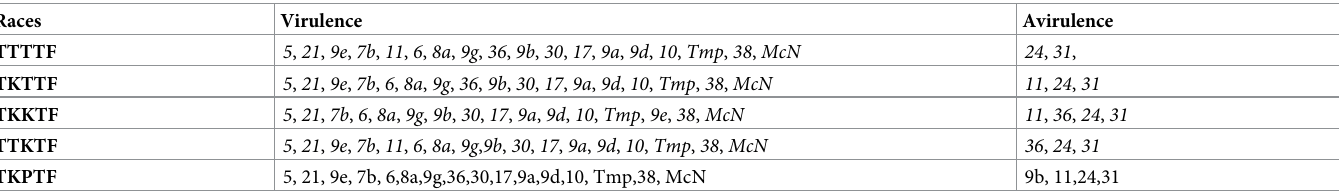
Table 6. Avirulence or virulence spectra of the Pgt races identified in 2018/19 and 2019/20 cool seasons irrigated wheat areas.